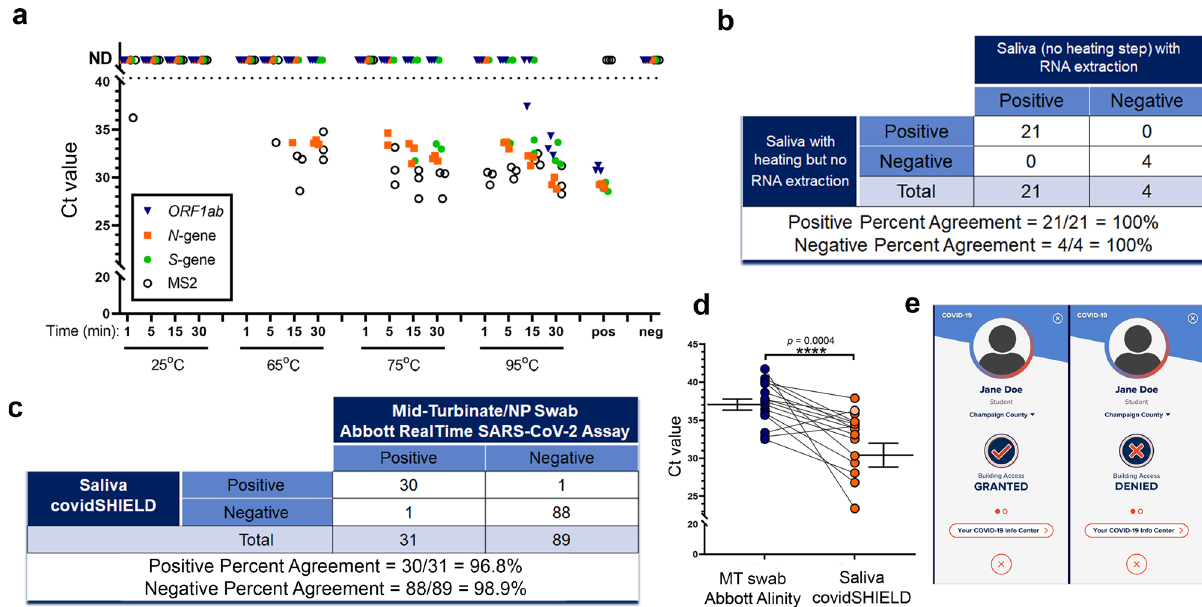
Fig. 2 Test and tell. a The effect of heat on SARS-CoV-2 nucleic acid detection in saliva. γ -irradiated SARS-CoV-2 (1.0 × 10 4 viral copies/mL) was spiked into fresh human saliva (SARS-CoV-2 negative). Samples diluted 1:1 with 2× Tris – borate – EDTA (TBE) buffer were incubated at 25 °C, or in a hot water bath at the indicated temperature and incubation time. All saliva samples were spiked with puri fi ed MS2 bacteriophage as an internal control and directly analyzed by RT-qPCR, in triplicate, for SARS-CoV-2 nucleic acid corresponding with ORF1ab gene, N -gene, and S -gene. Undetermined Ct values are